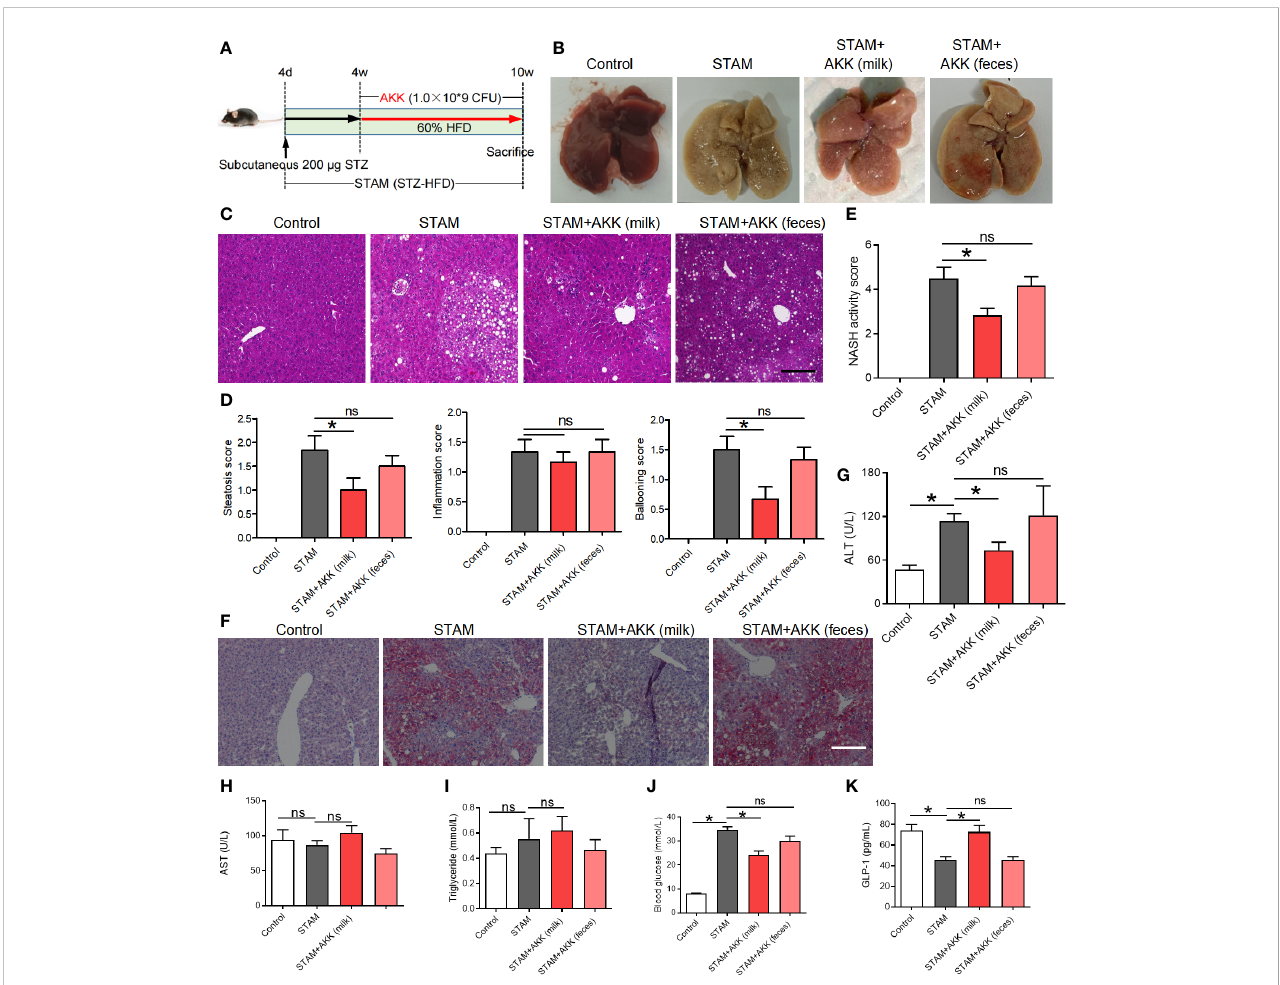
FIGURE 3 Supplementation with A muciniphila isolated from breast milk but not from stool improved nonalcoholic steatohepatitis in STAM mice. (A) Experimental design and protocol (n=6). (B) Representative macroscopic image of the liver surface and (C) histological images of liver tissues by H&E staining. Scale bars, 50 µm. (D) Steatosis, in fl ammation score and ballooning score were evaluated in the livers of STAM mice at 10 weeks of age. (E) The total NASH score was calculated by combining the sum of steatosis score, in fl ammation score, and ballooning score (n=6/group). (F) Oil-red stained liver tissues of STAM mice with or without A muciniphila adminstration. Scale bars, 50 µm. The serum ALT (G) , AST, triglyceride, blood glucose and GLP-1 (H-K) levels were measured. Data represent mean ± SEM of two pooled experiments. *P<0.05 vs STAM group by unpaired Student ’ s t test. ns, not signi fi cant. AKK, Akkermansia muciniphila ; ALT, alanine aminotransferase; AST, aspertate aminotransferase; GLP-1, glucagon-like